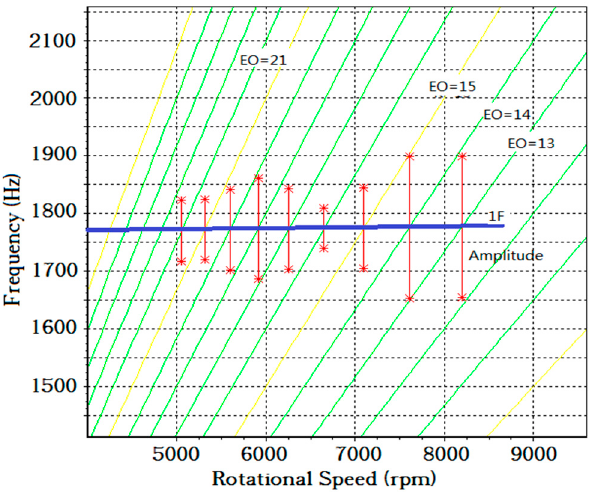
Figure 11. Campbell diagram of blade 6#.